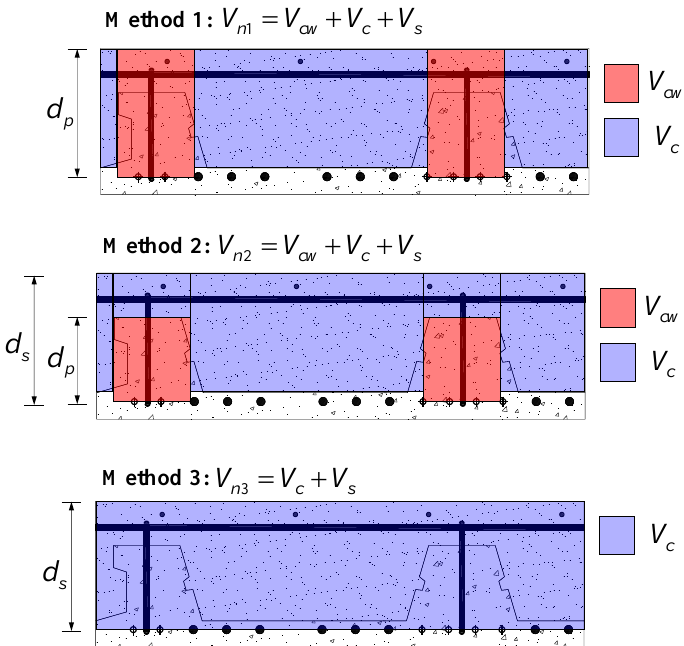
Figure 9. Shear strength estimation methods for composite member.